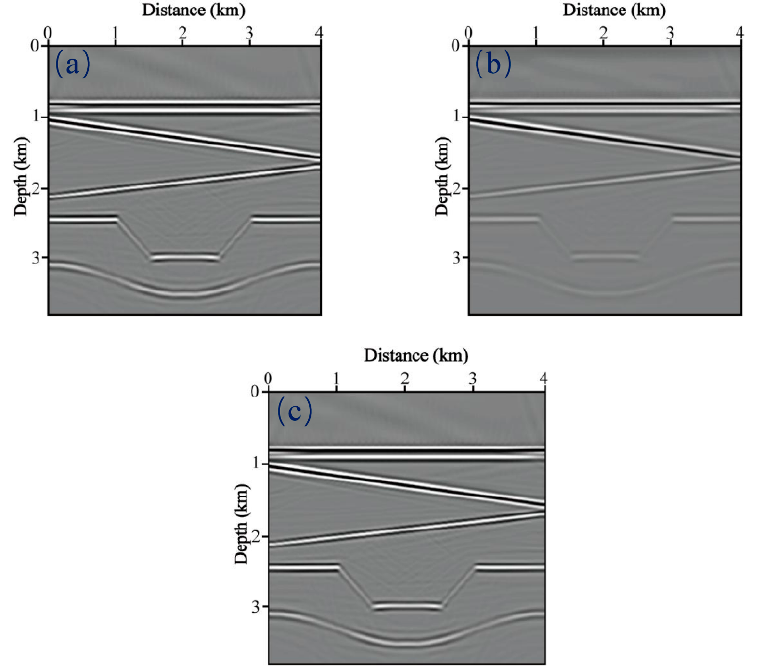
Figure 5. PS-images of the Sag model obtained by ( a ) the conventional ERTM from lossless seismic data, ( b ) attenuated seismic data without compensation, ( c ) attenuated seismic data with the proposed Q -ERTM scheme.